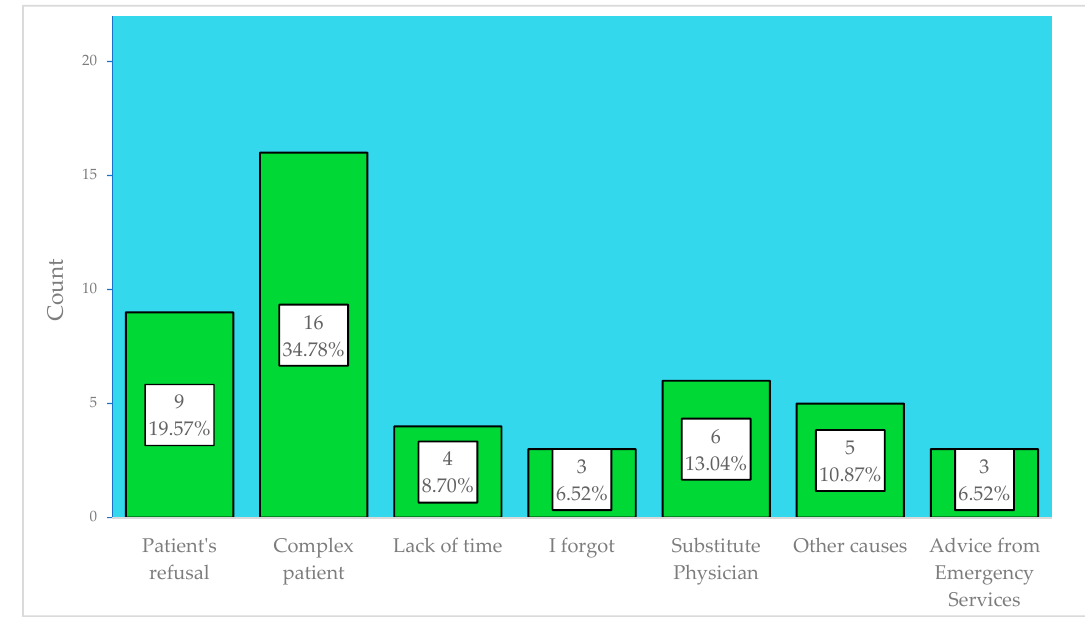
Figure 1. Causes of exclusion to telephone referral.